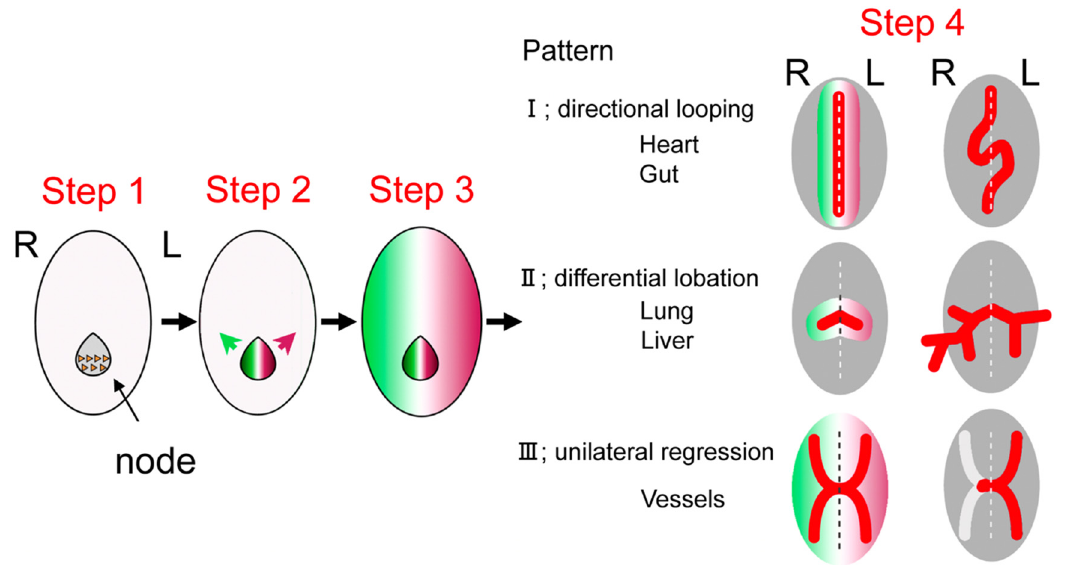
Figure 2. The four-step process of determining the left–right axis of the body including the heart. Step 1: rotational movement of cilia in the node, Step 2: right-to-left nodal flow of the embryo, Step 3: expression of the “left-sided formation mechanism” on the left side of the embryo, and Step 4: activation of left-sided formation molecules and genes (Nodal–Lefty–Pitx2) to pattern each organ in asymmetric fashion (adapted from [5] Yashiro K, Miyakawa S, Sawa Y (2017) Molecular Mechanism Underlying Heterotaxy and Cardiac Isomerism. Pediatric Cardiology and Cardiac Surgery 33, 349–361.).